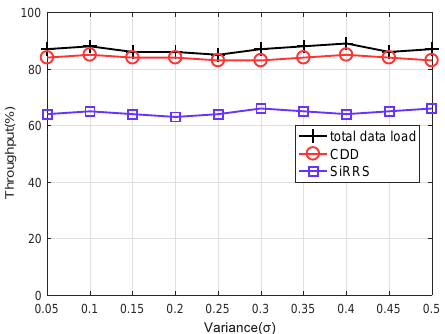
Figure 10. Throughput of heavy data load.